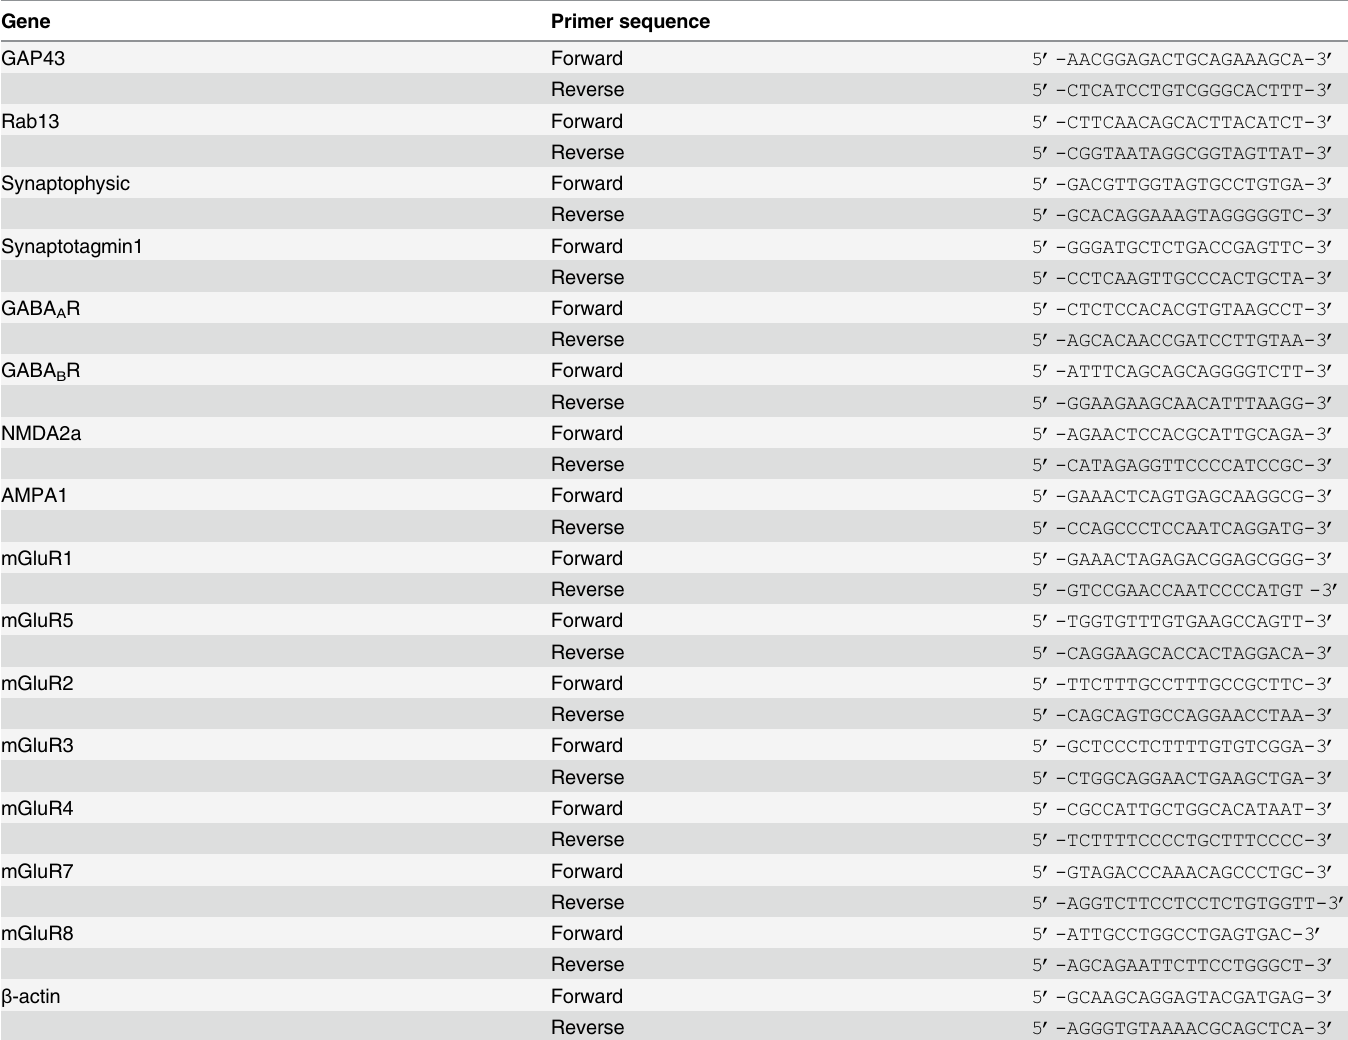
Table 2. Primer sequences for real-time PCR used in this